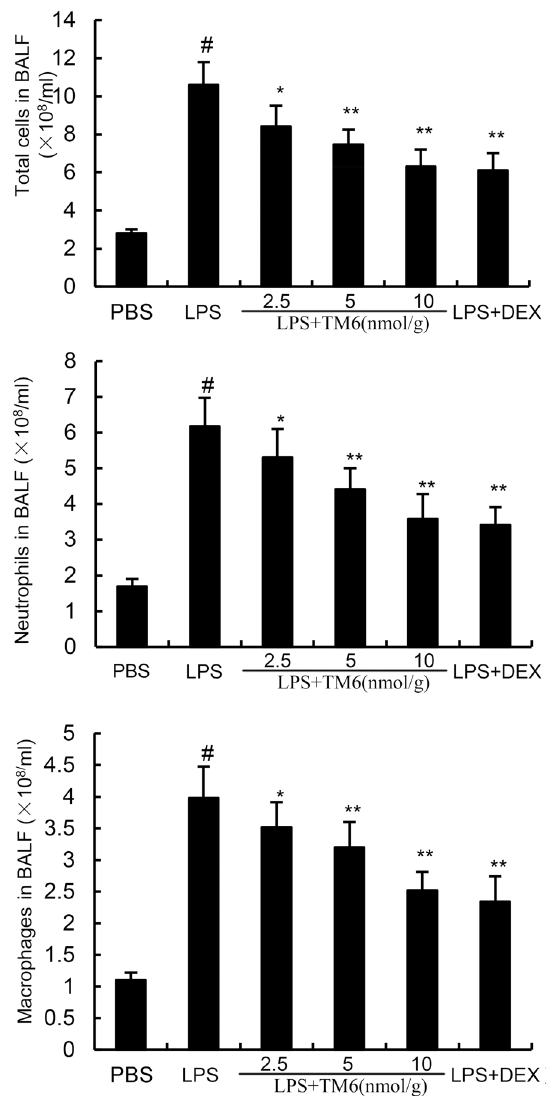
Figure 3. The effects of TM6 on the number of total cells, neutrophils, and macrophages in the BALF. Mice were given an intraperitoneal injection of TM6 (2.5, 5 and 10 nmol/g) and DEX (5 mg/kg) 1 h prior to an i.n. administration of LPS. BALF was collected 7 h after LPS administration to measure the number of total cells ( a ), neutrophils ( b ), and macrophages ( c ). The values presented are the means ± SEM (n = 6). # P < 0.01 is significantly different from the control group; * P < 0.05 and ** P < 0.01 are significantly different from the LPS